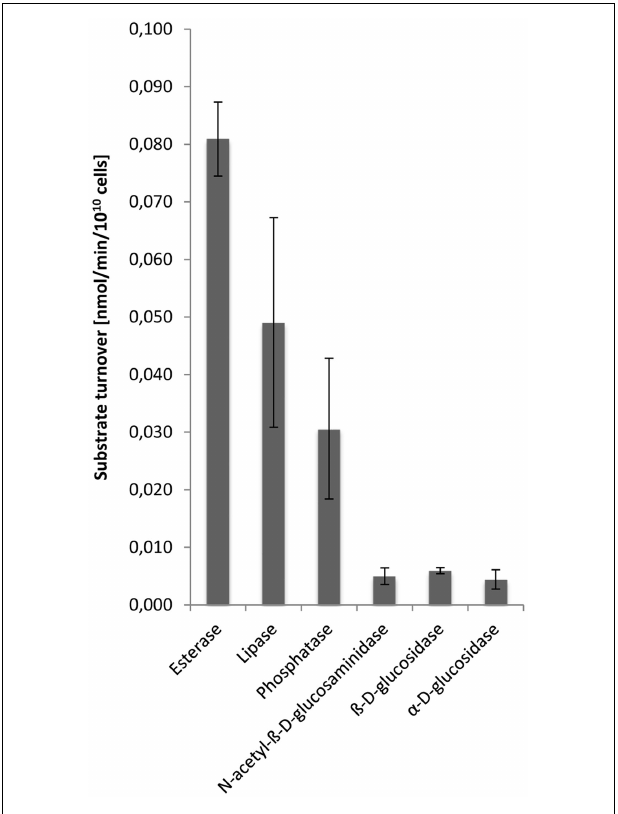
FIGURE 5 | Enzyme activities in the EPS from S. acidocaldarius biofilms . EPS were extracted with the CER method from unsaturated biofilms collected from Brock medium plates after 4days of incubation at 78°C. Enzyme activities in EPS solutions were determined at pH 3.5, using a microtiter plate assay as described in the Section “Materials and Methods.”